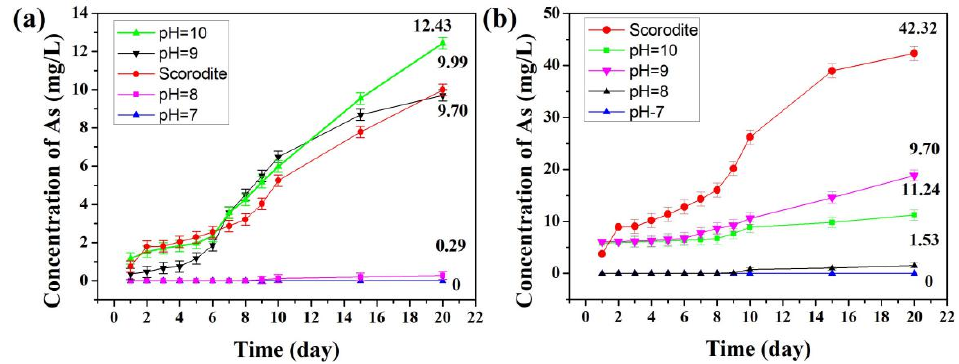
Figure 6. Leaching concentrations of arsenic over 20 days. Scorodite and scorodite@Fe 3 O 4 (initial Fe ions / scorodite molar ratio = 9%; initial reaction pH = 7, 8, 9, 10; reaction time = 35 min) with ( a ) pH 4.93 and ( b ) pH 9.30 solution. The scorodite@Fe 3 O 4 samples were synthesized at the indicated pH values and subsequently tested for stability using acidic and alkaline leaching solutions.